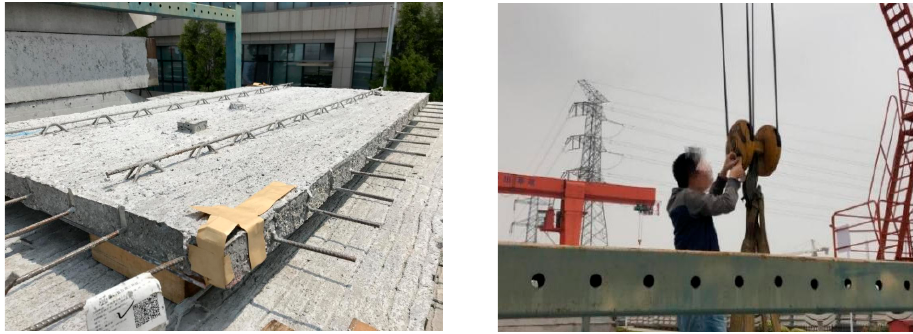
Figure 3. Schematic diagram of fixed IMU sensor position.